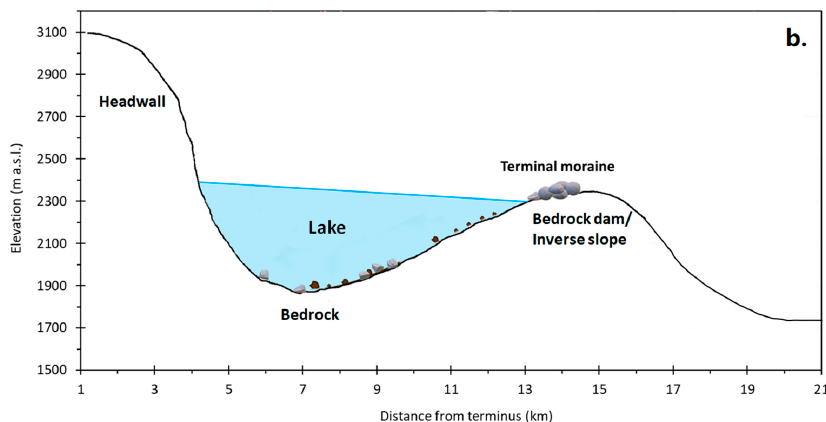
Figure 3. Two-dimensional cross-section of an overdeepening ( a ) and the process of lake formation after glacier retreat ( b ). The blue arrow in ( a ) shows the direction of ice flow. With: